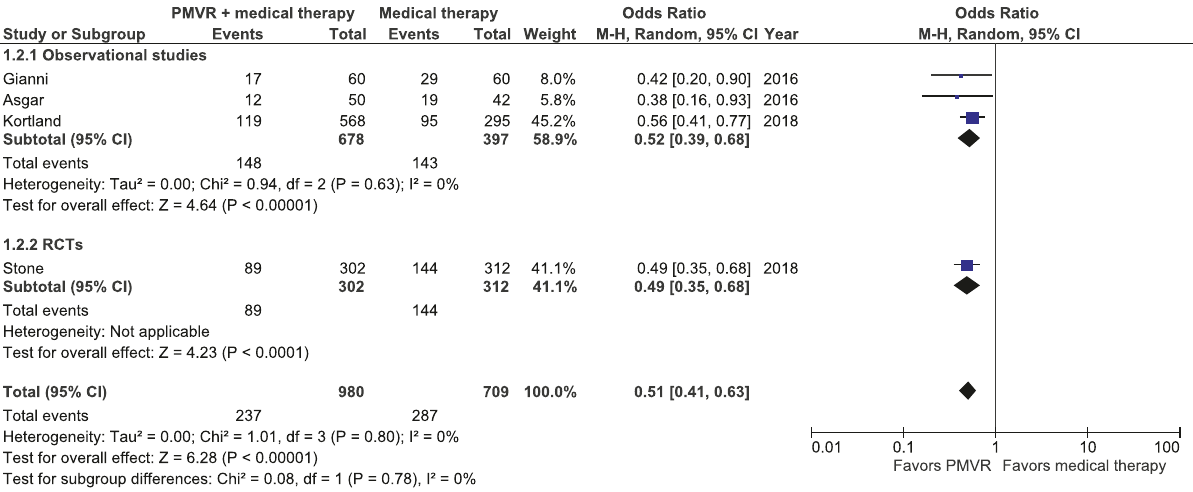
Figure 3: Forest plot displaying the risk of 2-year mortality in the PMVR group compared to the OMT